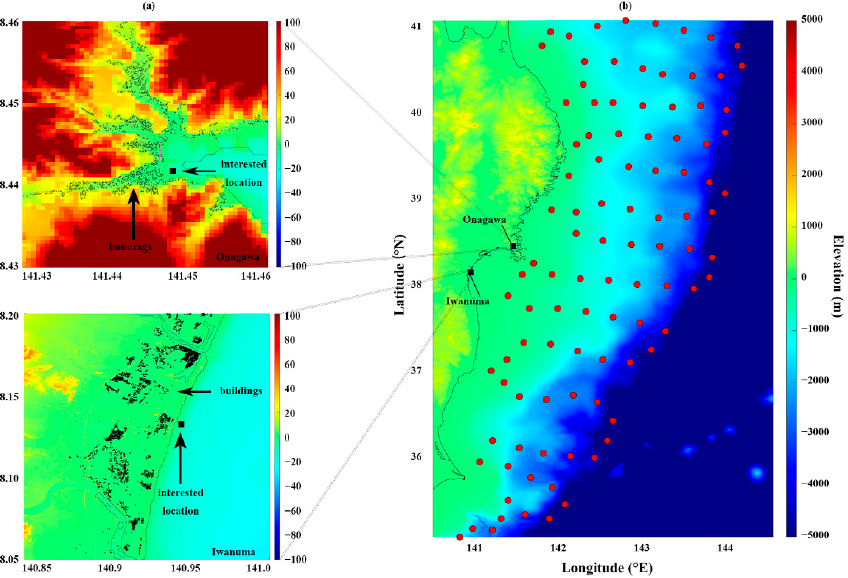
Figure 2. Map of the off-shore sensors and two interested nearshore locations. ( a ) Zoomed maps of the two interested coastal towns, Onagawa and Iwanuma. The black squares represent the locations where the maximum on-shore wave amplitude is forecasted for the hazard-based algorithm. ( b ) The 99 off-shore sensors used in this study.